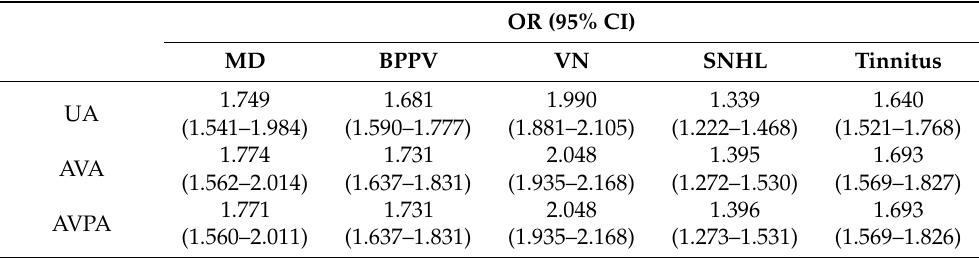
Table 5. ORs for vestibular and cochlear disorders in non-migraine headache patients after